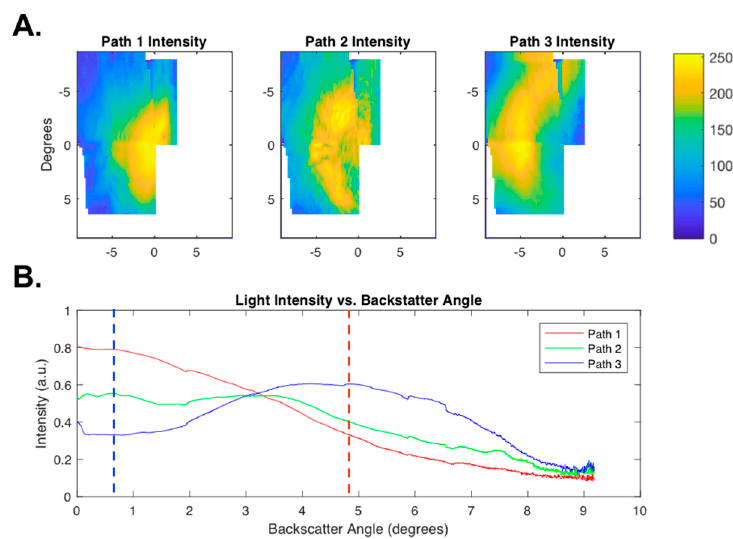
Figure 12. ( A ) The peak intensity of each pathlength as a function of angular deviation due to the dual-axis MEMS mirror raster scanning. Several images were stitched together to form a more complete dataset. ( B ) The azimuthal average of each pathlength intensity. The blue dashed line matches the location of the blue line in Figure 11. The red dashed line matches the location of the red line in Figure 11.